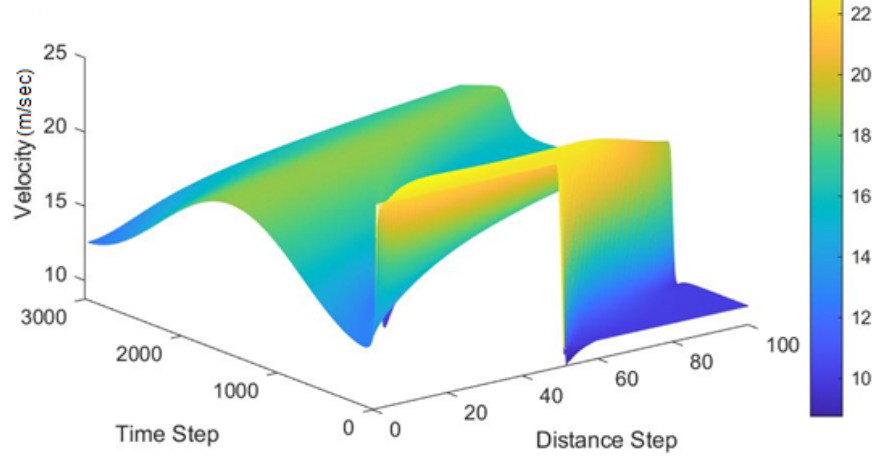
Figure 6. Velocity behavior of proposed model on straight road with ingress traffic.